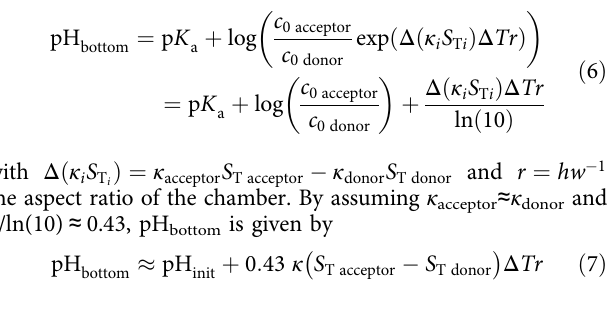
where c acceptor and c donor denote local proton acceptor and proton donor concentrations, respectively. Given suf fi ciently high buffer concentrations, the pH is only affected by the ratio of proton acceptors to donors, and not by their total concentrations. The pH at the bottom of the chamber pH bottom is therefore derived by calculating the corresponding proton acceptor/donor concentra- tion at the bottom, given by Eq. (2) at equilibrium.